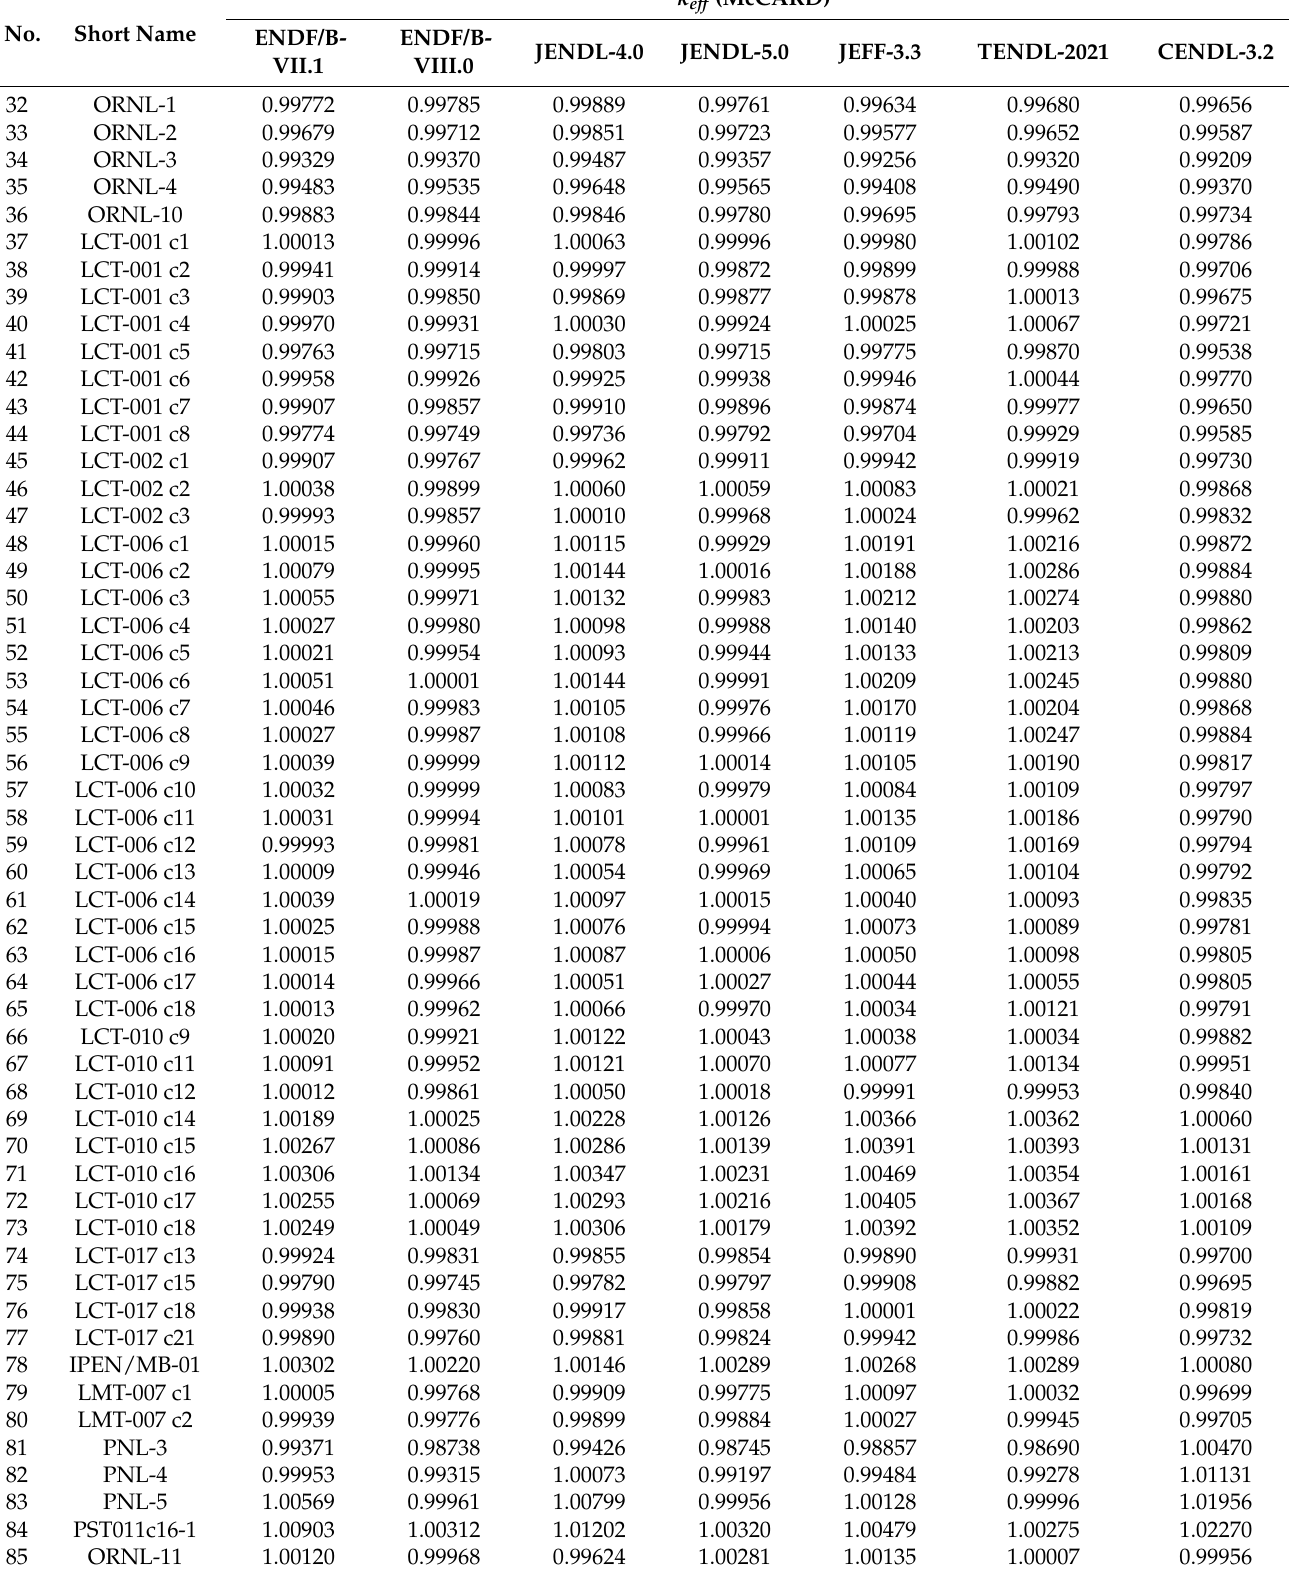
Table 5. k eff values for the thermal benchmarks with the different evaluated nuclear data